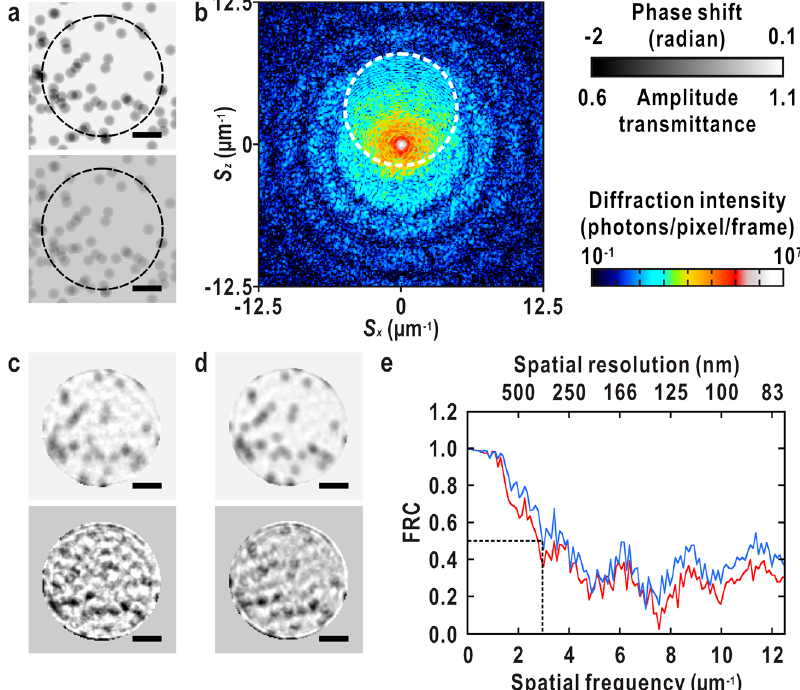
Fig. 4 Image reconstruction from a single-shot diffraction pattern obtained with the projection illumination optics. a Selected frame of the model at glycerine concentration of 90%w/v and temperature of 283 K. Phase (upper) and absorption (lower) images of the object transmission functions averaged over the frame time are shown. The object model at the 500th frame is used. The illuminated area is indicated with the broken circles. b Simulated diffraction intensity pattern accumulated over the dwell time. The bright- fi eld region is indicated with the broken line. Phase (upper) and absorption (lower) contrast object frames of c single and d averaged reconstructions. e Fourier ring correlation (FRC) curves for the single (red) and averaged (blue) reconstruction. The broken line indicates a 0.5 threshold and corresponding spatial frequency. The grayscale for ( a , c , d ) and the colour scale for ( b ) are shown in the upper-right area of the panel. Scale bars indicate 1 μ